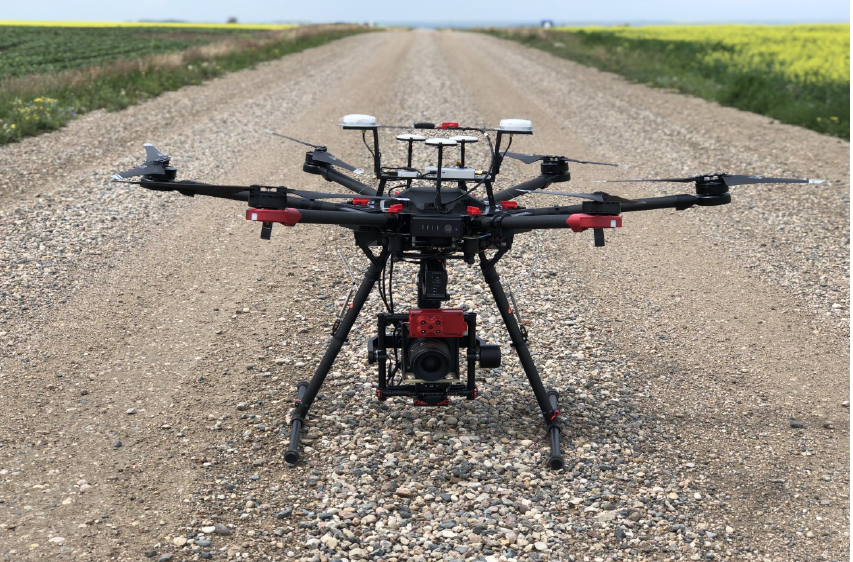
Figure 1. The two sensors co-mounted on a UAV. The red sensor is the Micasense Rededge (LR images) and the black sensor is IXU-1000 PhaseOne (HR